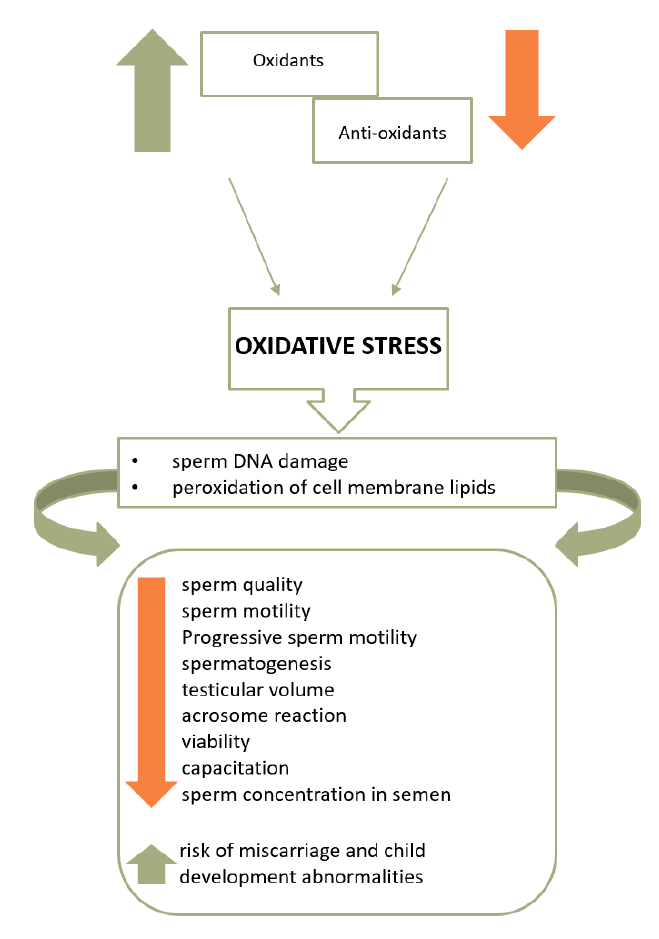
Figure 2. The influence of oxidative stress on sperm quality and fertility [11,65].